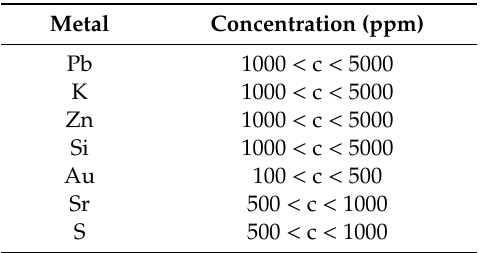
Table 1. Metals other than manganese and their content in tested soil sample. “c” represents the range in which the content of the given metal was in the tested